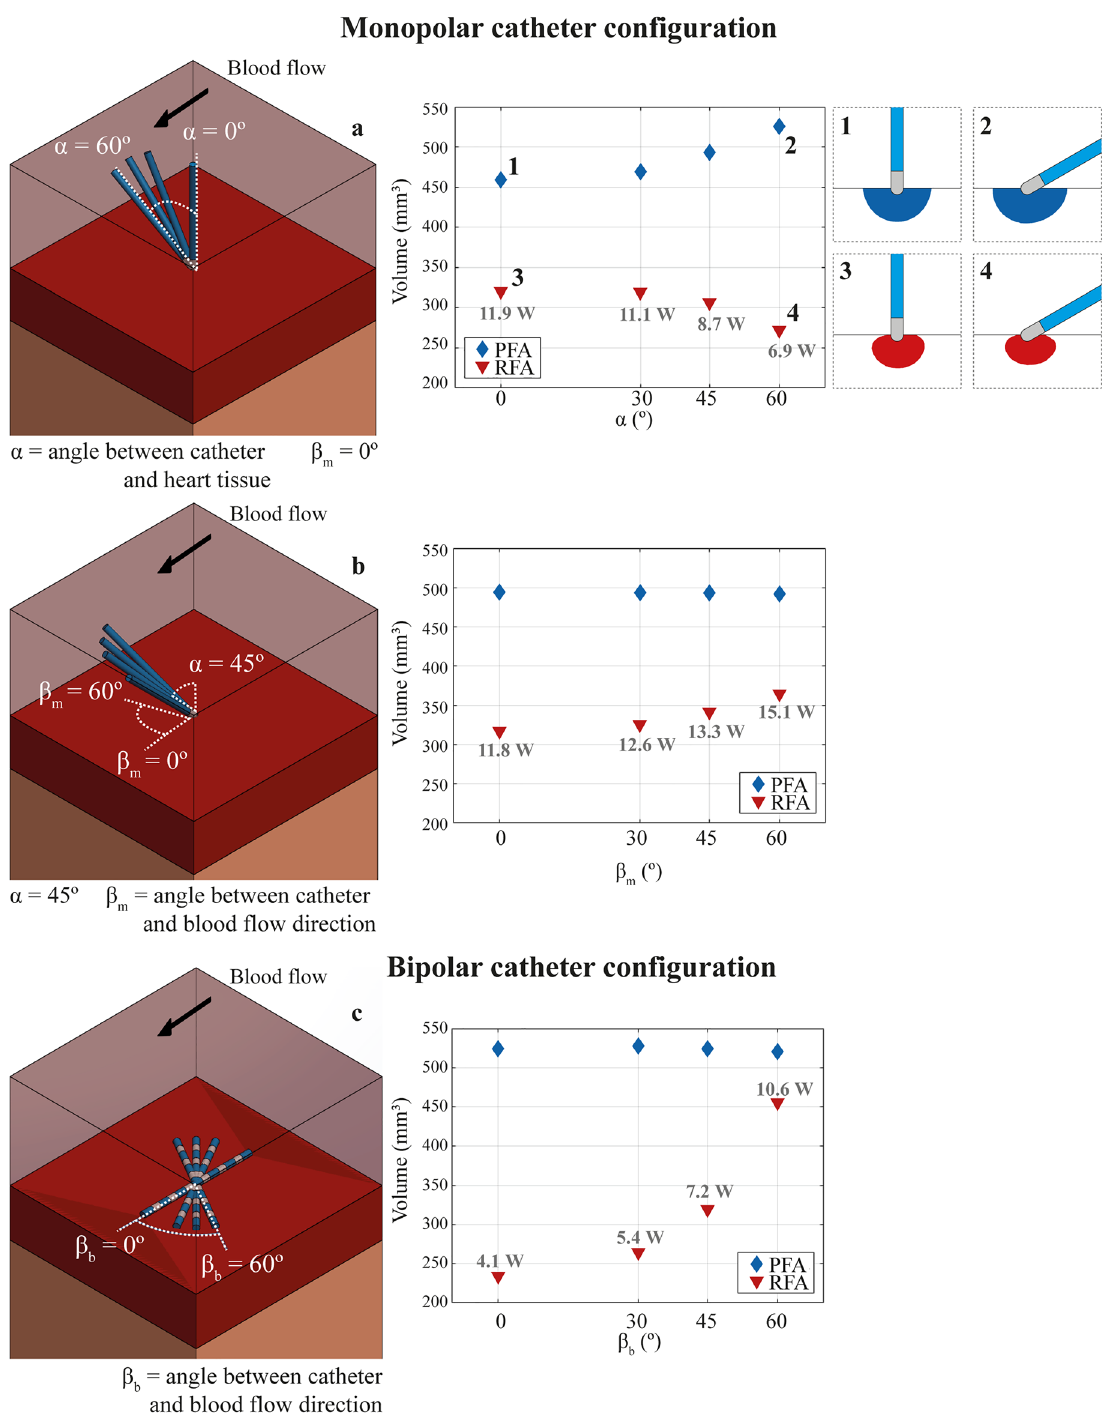
Figure 4. Dependence of the lesion on the angle of the catheter with the cardiac surface ( α ) and with the blood flow ( β m and β b ) for ( a ) and ( b ) monopolar and ( c ) bipolar catheter configurations for RFA (inverted red triangle) and PFA (blue diamond). ( a ) Lesion volumes obtained for a fixed value of β m Right inset depicts the lesion shapes predicted for ( a.1 and a.2 ) PFA and ( a.3 and a.4 ) RFA for angles α 60 ◦ , respectively. ( b ) Lesion volumes obtained for a fixed value of α = 45 ◦ and varying β m . ( c ) Lesion and α = volumes obtained for different values of β b (angle between the catheter and the blood flow direction) in the bipolar catheter configuration. The mean power applied (mean value of the complete application time, 30 s) is shown for RFA in all